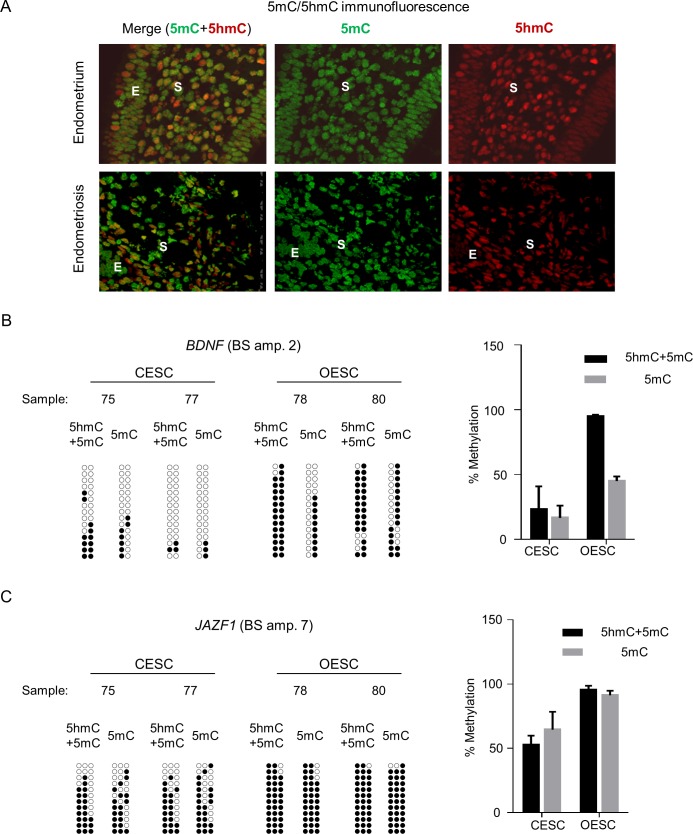
Analysis of 5mC and 5hmC in endometriosis lesions and stroma cells.A) Immunofluorescence analysis of the levels of expression of 5mC (green) and 5hmC (red) in tissue samples of women with endometriosis and controls, showing disease-dependent loss of 5hmC in the epithelial but not in the stromal cell compartment. Representative photos from a total number of n = 2 control and n = 2 endometriotic tissue are shown. B) The results of the standard and oxidative bis-seq for BDNF in endometriotic and control stromal cells represented as QUMA plots (left) and as bar graph (right). The QUMA plot and bar-graph show the percent methylation assessed by standard bis-seq (which scores indistinctly 5hmC and 5mC) and by modified bis-seq (which scores 5mC only) in control stroma and endometriotic stroma cells. The contribution of 5hmC in endometriotic and control stroma is inferred from the difference between the percent methylation at each CpG in the standard bis-seq reactions (5hmC + 5mC) and the percent methylation in the modified bis-seq reactions (5mC). C) The data of JAZF1 standard and oxidative bis-seq in endometriotic and control stromal cells represented as QUMA plots (left) and bar-graph (right) are shown.